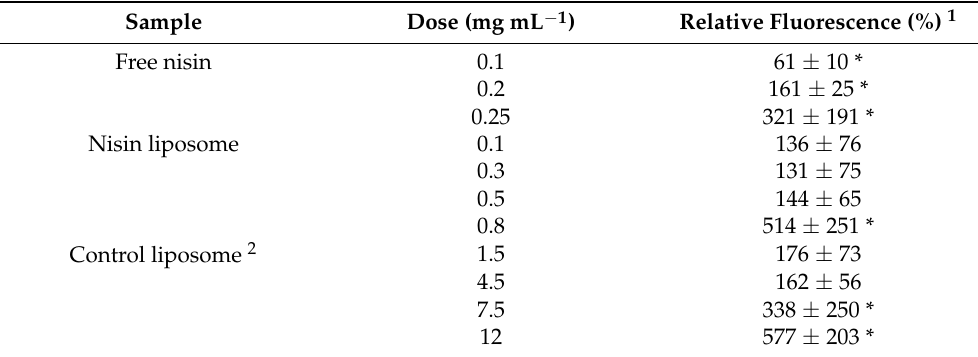
Figure 2. Influence of nisin and liposomes on the development of C. elegans . Controls were per- formed by incubation in saline solution (0.085 mol L − 1 NaCl) or in the presence of empty liposomes. Values for control liposomes are expressed as PC concentration, corresponding to the equivalent PC amount of liposomes containing 0.1, 0.3, 0.5, and 0.8 mg mL − 1 nisin, respectively. Values are the means ± standard deviations of three independent experiments. * denotes significant differences with control saline ( p < 0.05). Table 1. Reactive oxygen species levels measured by fluorescence emission from 2 (cid:48) 7 (cid:48) -dichlorofluorescein- diacetate